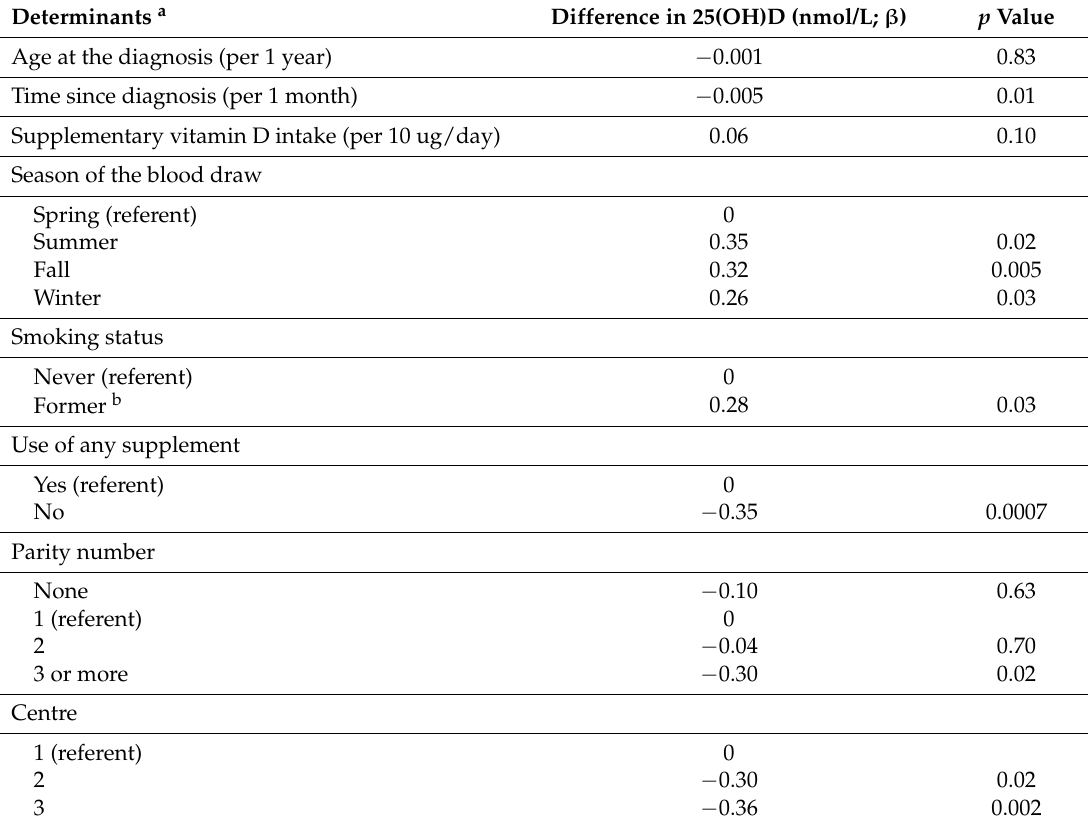
Table 2. Determinants of plasma 25(OH)D concentrations in the training